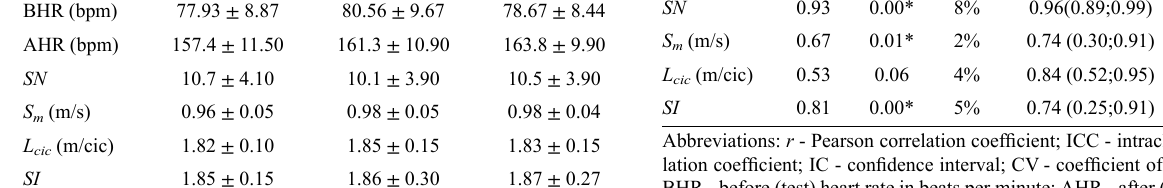
Table 1 - Descriptive values on different test days applied to master swimmers. Variable